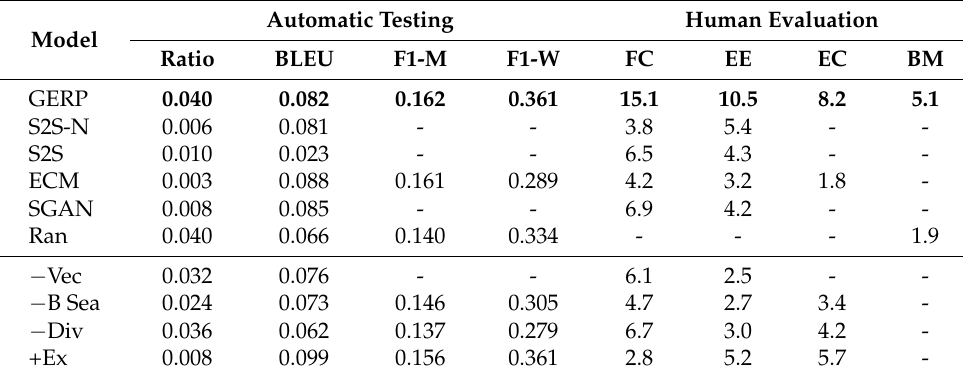
Table 4. The experimental result of GERP and the comparison models. The results of GREP are